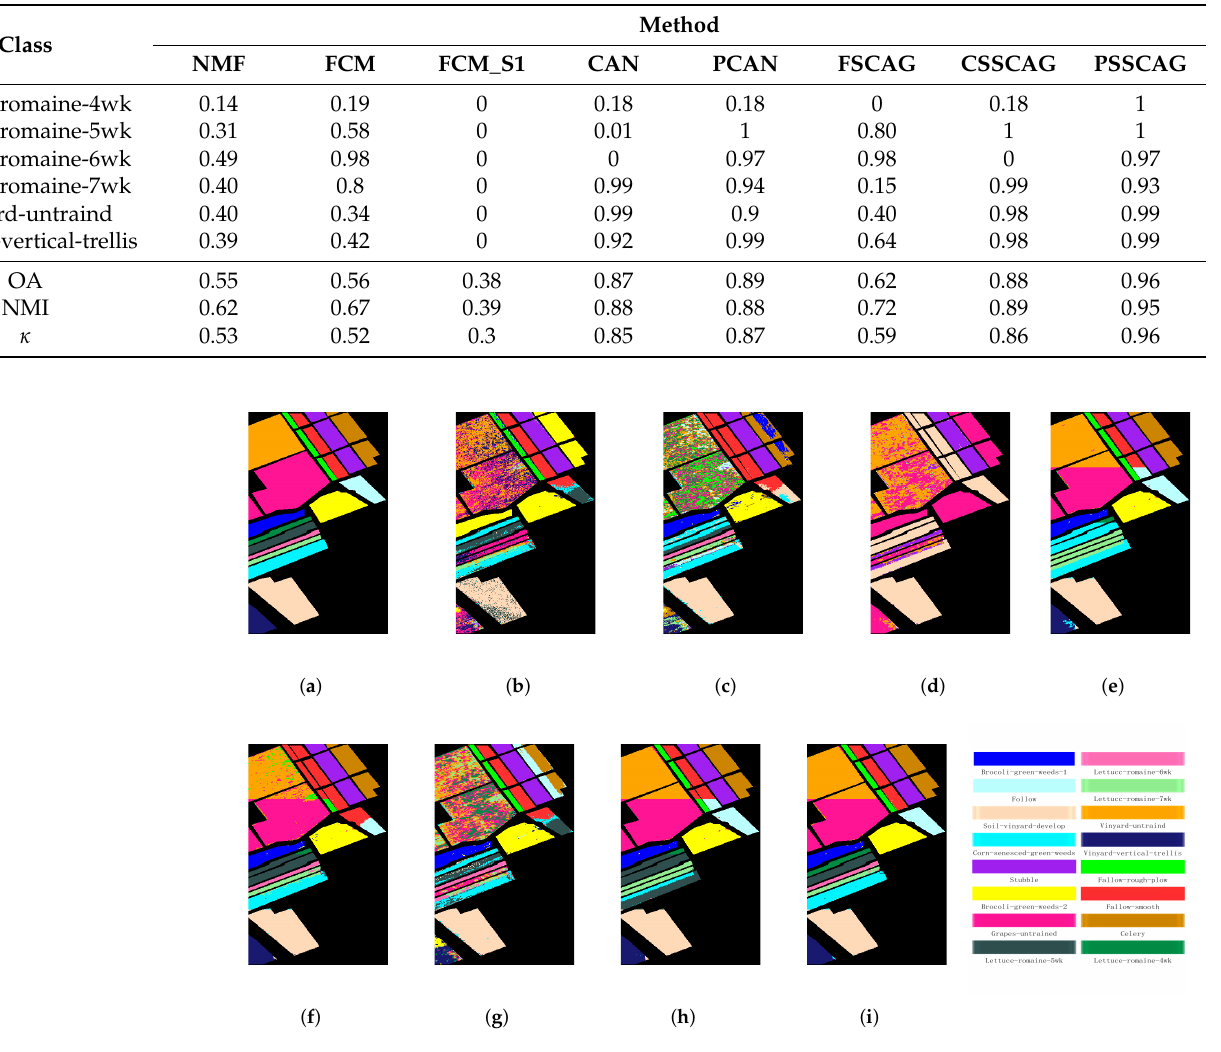
Figure 8. Cluster maps of different methods for the Salinas dataset. ( a ) Ground truth, ( b ) NMF, ( c ) FCM, ( d ) FCM_S1, ( e ) CAN, ( f ) PCAN, ( g ) FSCAG, ( h ) CSSCAG, and ( i )